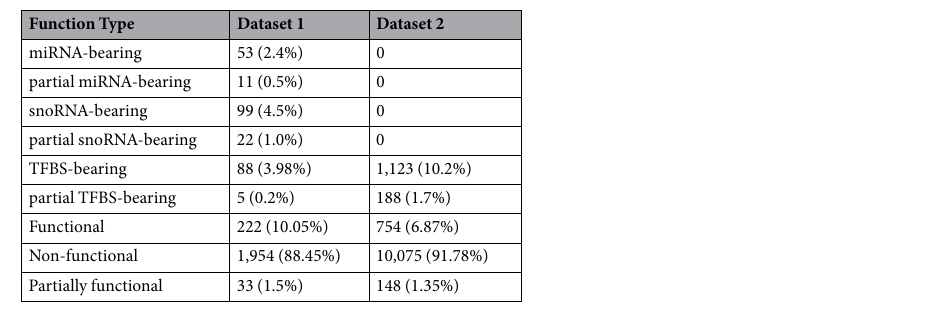
Table 1. Unique patterns composition in Datasets 1 and 2. The ‘Functional’ row is the union of all three functions, counting unique patterns that are functional. Some unique patterns are associated with more than a single function, leading to the fact that the number of functional unique patterns (222) is less than the sum of miRNA-, snoRNA- and TFBS-bearing unique